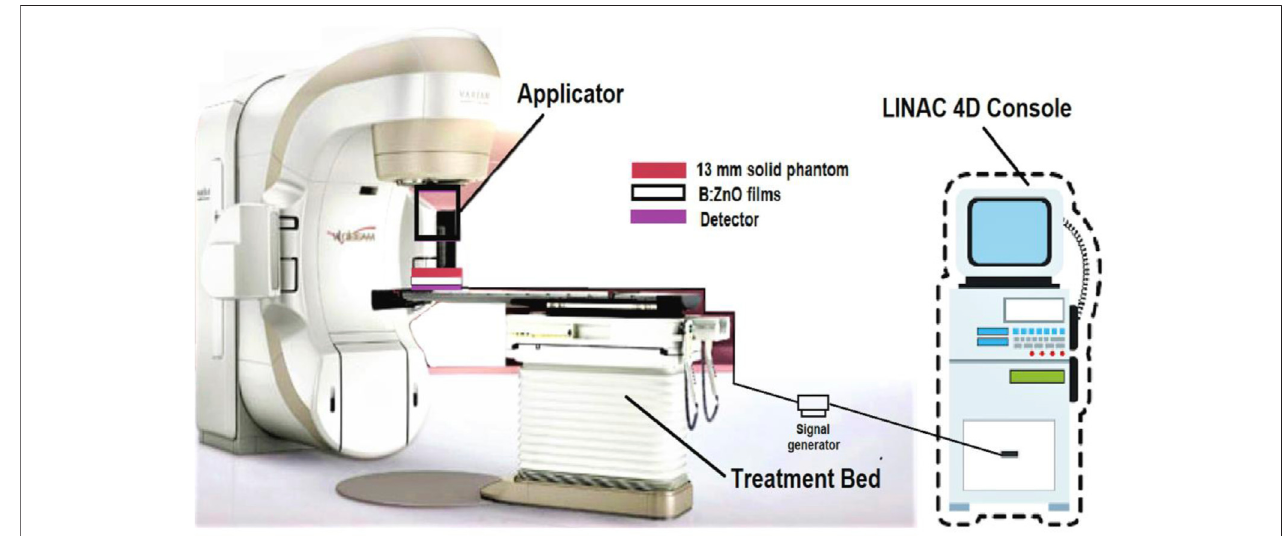
FIGURE 1 | Schematic illustration of the experimental setup for radiation protection